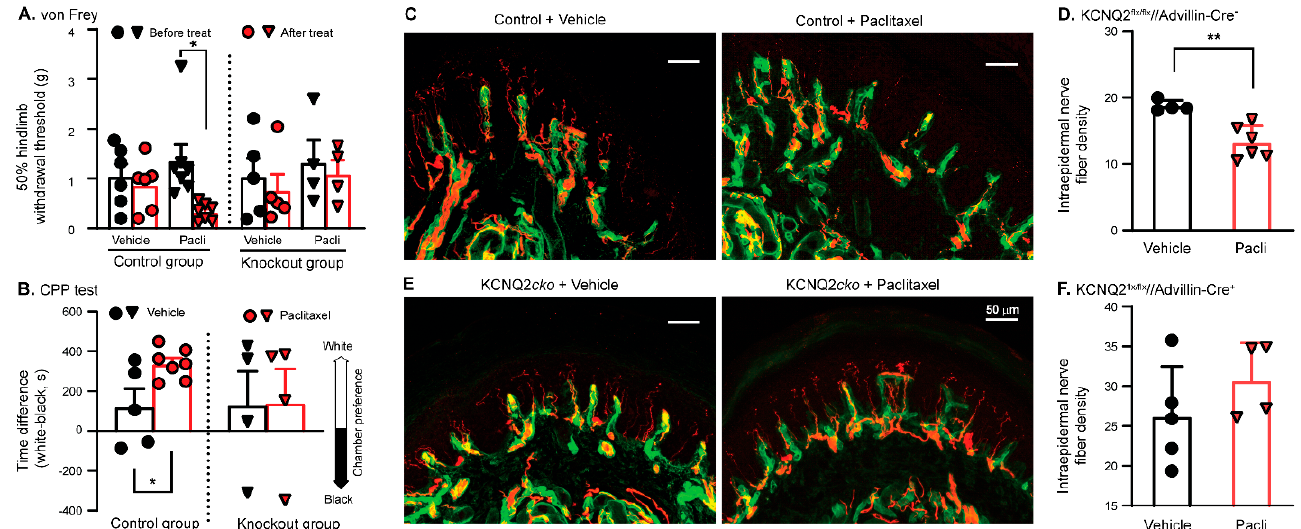
Figure 6. Effect of KCNQ2 deletion from primary sensory neurons on the development of PIPN. ( A ) Development of mechanical hypersensitivity in the hind paws (tested 3 weeks after final paclitaxel/vehicle application) of control and KCNQ2 cko mice. Control group: p = 0.5814, t(5) = 0.5890 for vehicle; p = 0.0166, t(6) = 3.293 for paclitaxel, two-tailed paired Student’s t test. KCNQ2 cko group: p = 0.2592, t(4) = 1.314 for vehicle; p = 0.3944, t(3) = 0.9918 for paclitaxel, two-tailed paired Student’s t test. Colored symbols in columns represent one mouse each. ( B ) Comparison of CPP responses between control and KCNQ2 cko mice that received vehicle or paclitaxel injections. Animals were tested 4 weeks after the last injection. Symbols in columns represent individual mice (control and KCNQ2 cko ). p = 0.0252, t(10) = 2.629, unpaired t test (two-tailed) for control group; p = 0.9694, t(6) = 0.03997, unpaired t test (two-tailed) for KCNQ2 cko group. *, p < 0.05; **, p < 0.01;. Pacli, paclitaxel. ( C ) Images showing skin IENFs (stained with PGP9.5, red) that crossed the basal lamina (stained with collagen IV, green) in control mice receiving vehicle or paclitaxel injections. Scale bars, 50 μ m. ( D ) Summary data showing the density of IENFs in the epidermis of control mice that did and did not receive paclitaxel injections. Filled symbols in the bar graph represent individual control mice. p = 0.0031, t(8) = 4.184, unpaired t test (two-tailed). ( E ) Images showing skin IENFs (red) that crossed the basal lamina (stained with collagen IV, green) in KCNQ2 cko mice that underwent vehicle or paclitaxel injections. Scale bars, 50 μ m. ( F ) Summary data showing the density of skin IENFs from KCNQ2 cko mice that did and did not receive paclitaxel injections. Filled symbols in columns represent individual mutant mice. Data are represented as mean ± SEM. p = 0.2762, t(7) = 1.181, unpaired t test (two-tailed).